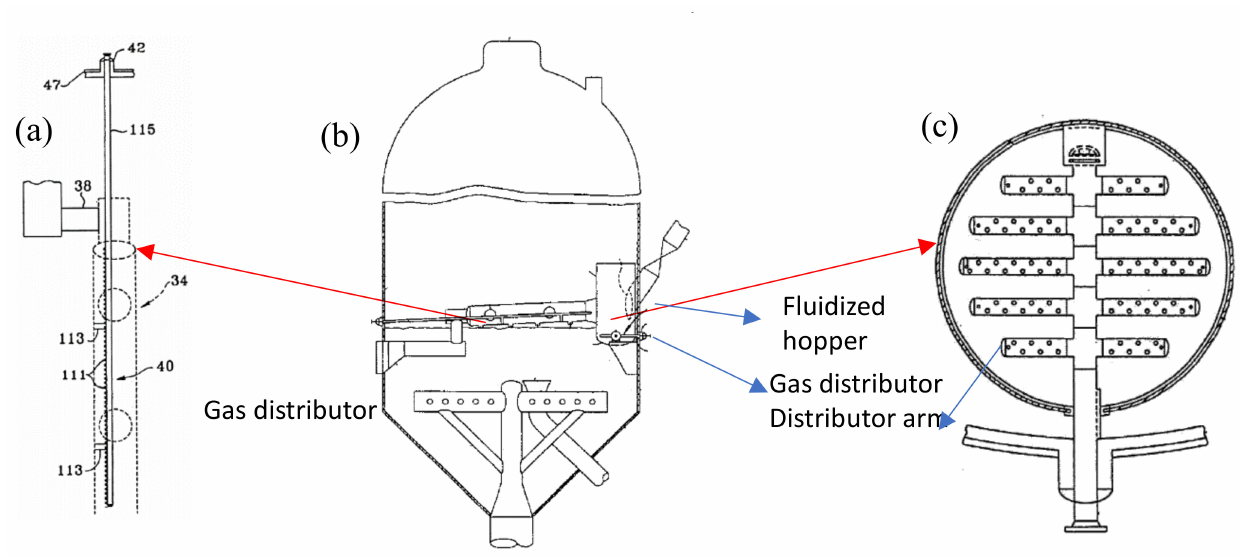
Figure 13. Sidewall spend catalyst distributor: ( a ) aeration lancer ( b ) regenerator with distributor ( c ) horizontal header. Adopted from Myers et al. [91]. Fluidized hopper located at regenerator sidewall receives spent catalyst and a horizontal header extended across dense bed cross section distributes the catalyst through its multiple arms while the lance inside the header provides supplementary transport gas for uniform catalyst spray .